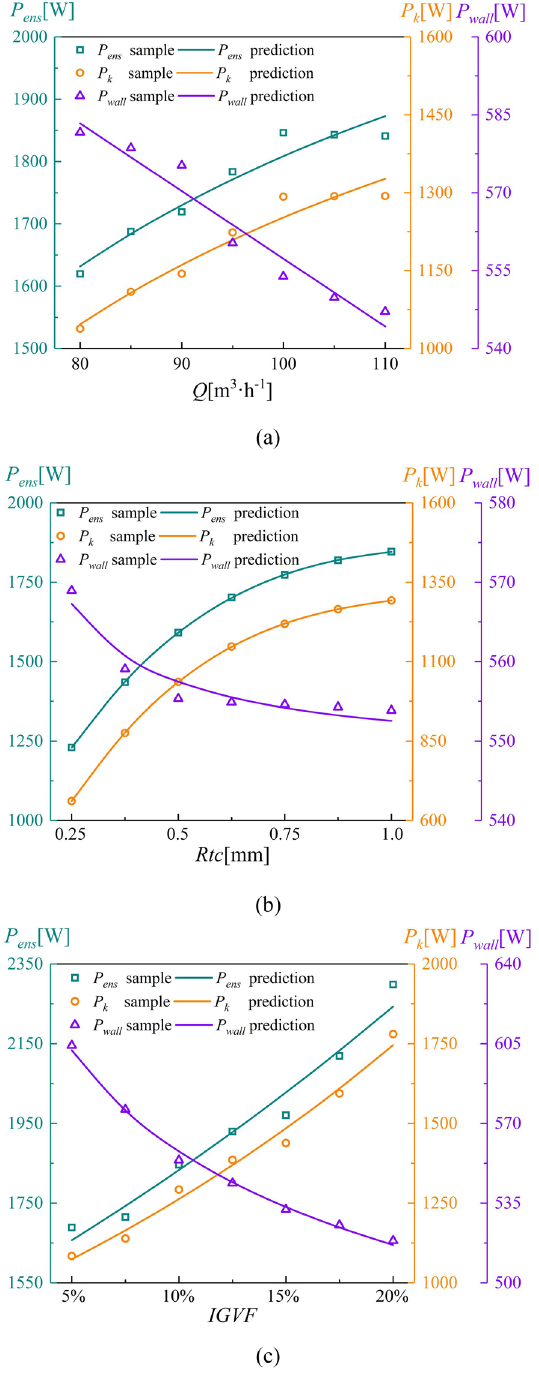
Figure 16. Prediction curves of the enstrophy dissipation power with different variables. ( a ) Flow rate, ( b ) tip clearance, and ( c )